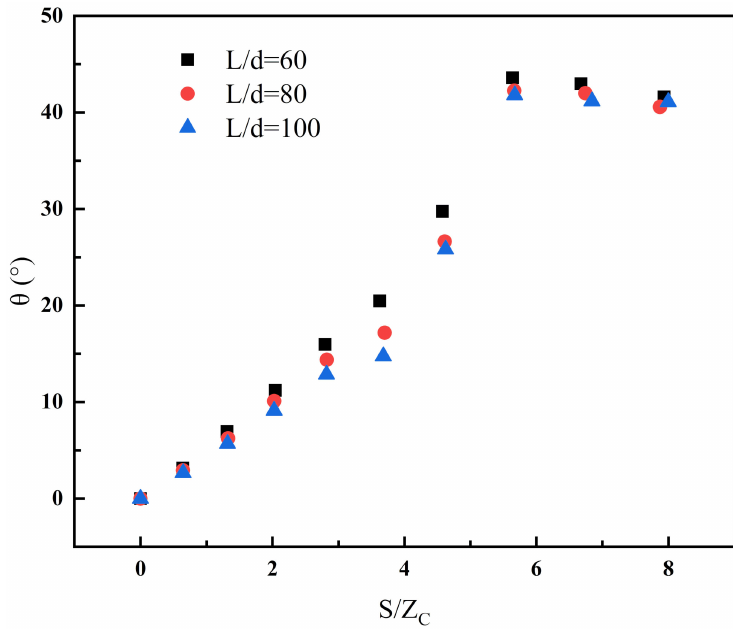
Figure 13. The changing trend of the flame tilt angle θ with S/Z C